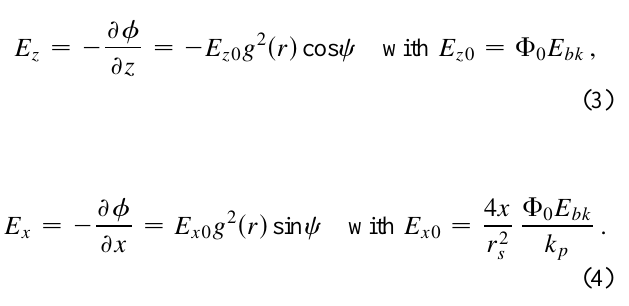
FIG. 1. Schematic illustrations of laser-wakefield